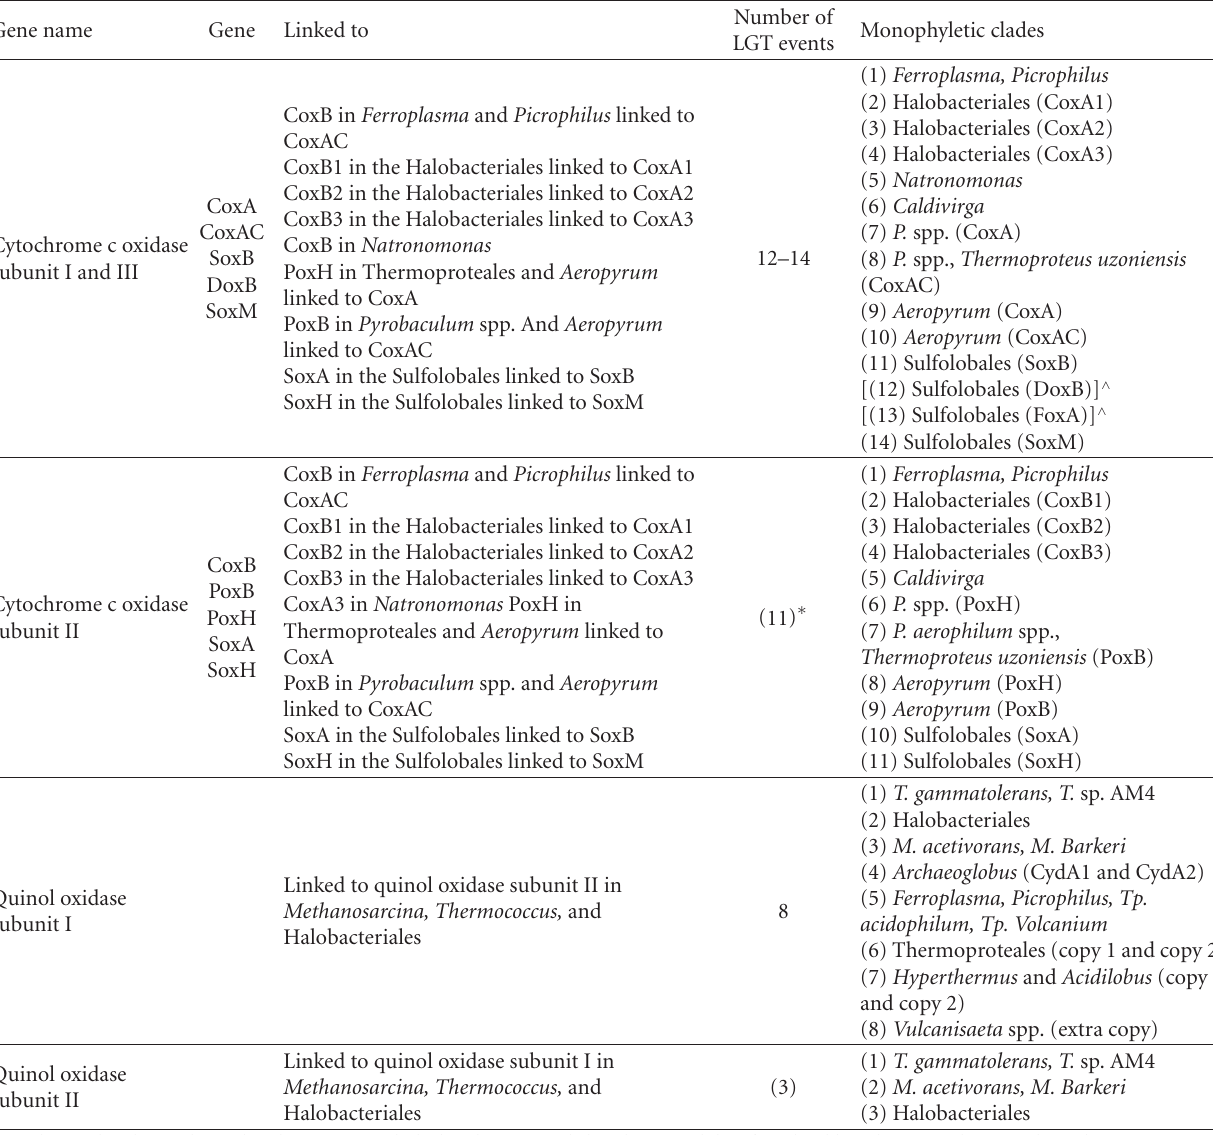
Table 1: Aerobic